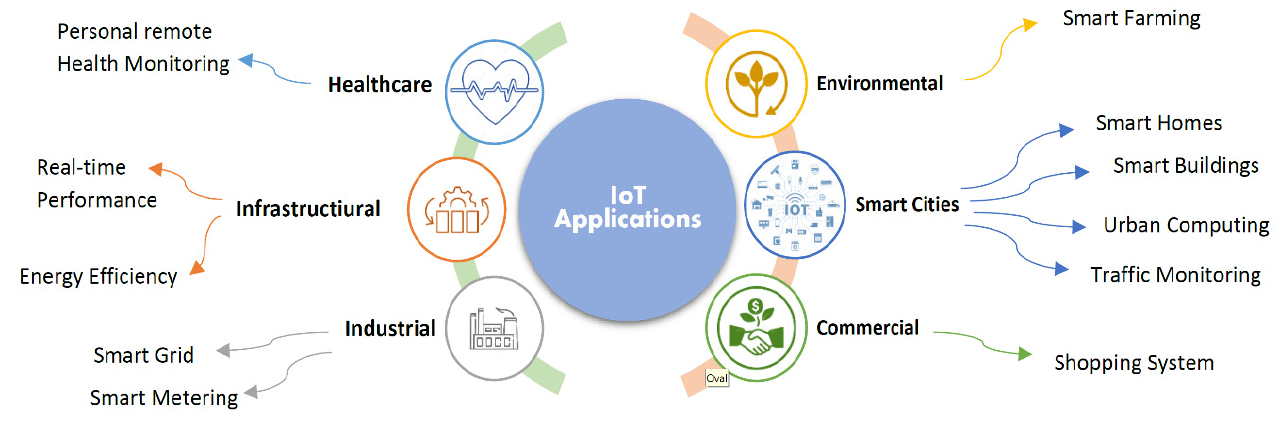
Figure 4. The classification of IoT applications .